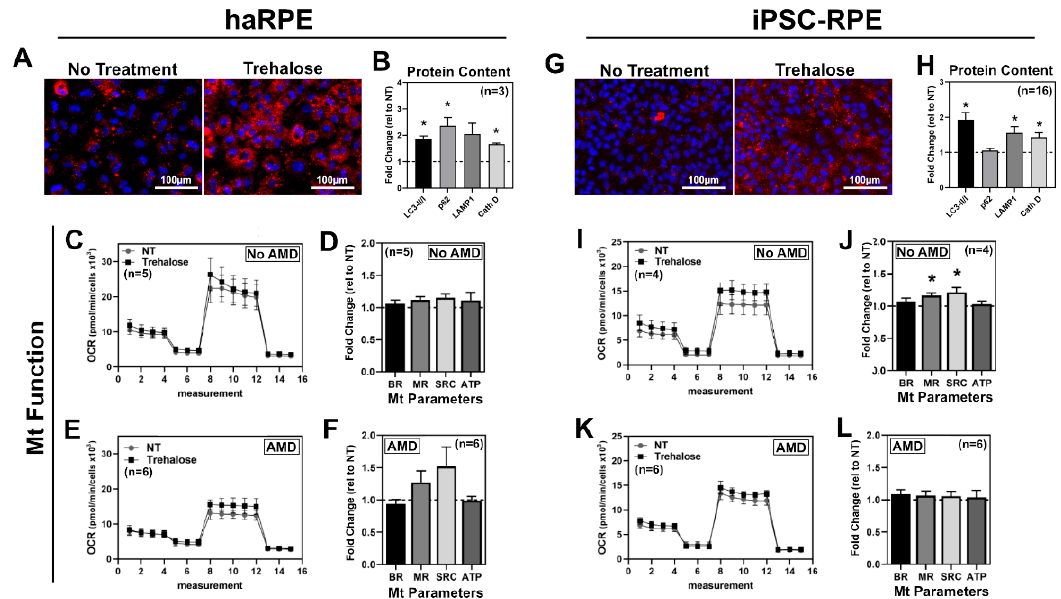
Figure 4. Response to trehalose. haRPE ( A – F ) or iPSC-RPE ( G – L ) were treated with 100 mM trehalose for 48 h. ( A , G ) Lysotracker (red) and nuclei (blue) max-intensity projections of 20 × magnification images from no treatment (left) or after trehalose treatment (right). ( B , H ) Quantification of autophagy and lysosmal proteins. ( C , I ) OCR trace from No AMD donors for no treatment (NT) or after treatment. ( D , J ) Mitochondrial (Mt) functional parameters from No AMD donors. ( E , K ) OCR trace from AMD donors for no treatment (NT) or after treatment. ( F , L ) Mitochondrial functional parameters from AMD donors. Sample size indicated in panel for each assay. * denotes p < 0.05.